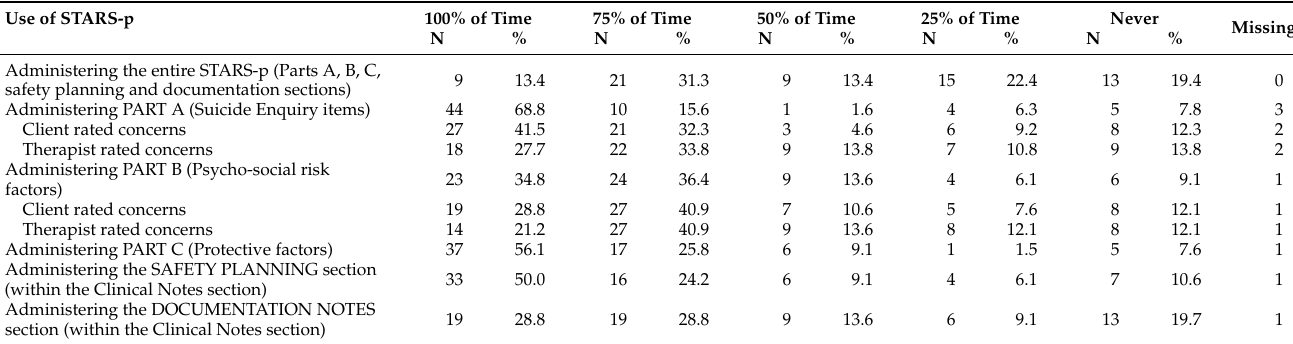
Table 2. Use of entire STARS-p and sections of the